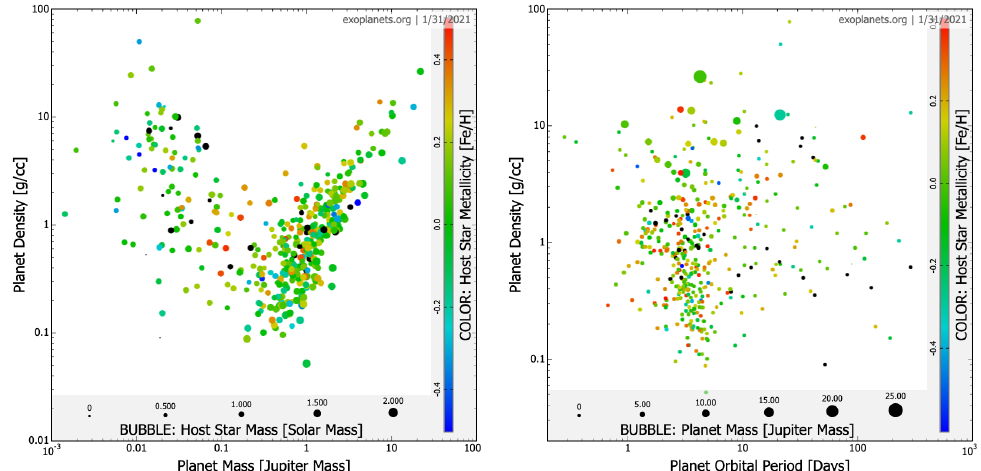
Figure 6. Exoplanet characteristics: planet density (both panels, y -axis), planet mass ( Both Pan- els , x -axis or bubble-size), planet orbital period ( Right Panel , x -axis), host–star metallicity [Fe/H] ( Both Panels , color), and host–star mass ( Left Panel , bubble-size). Source: the Exoplanet Orbit Database